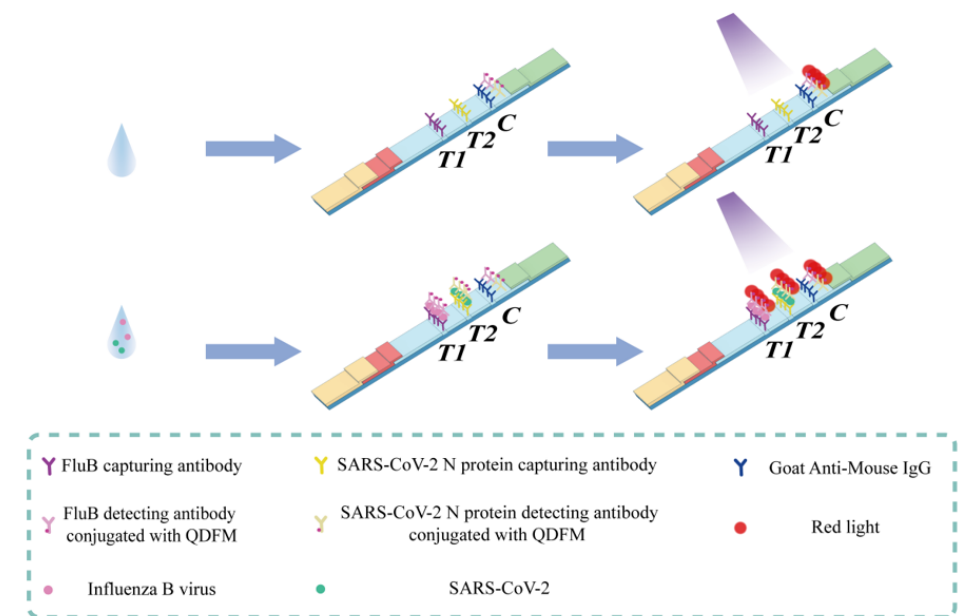
Figure 3. Illustration of the FluB/SARS-CoV-2 ICTS.